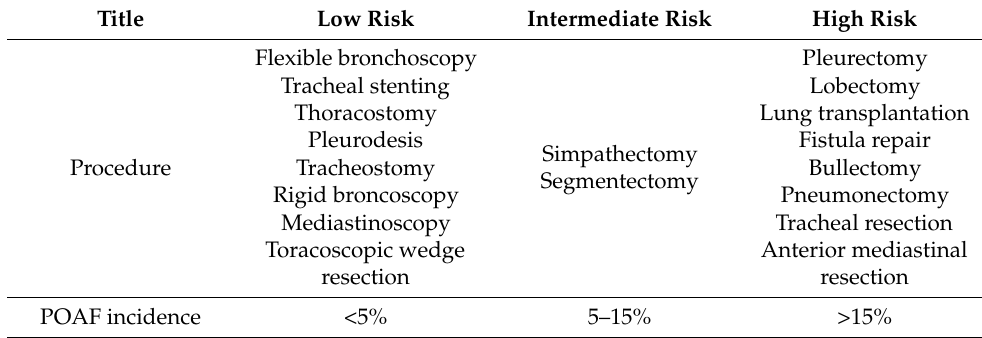
Table 2. POAF risk per type of thoracic surgery procedure. Modified from Fabiani I. et al.